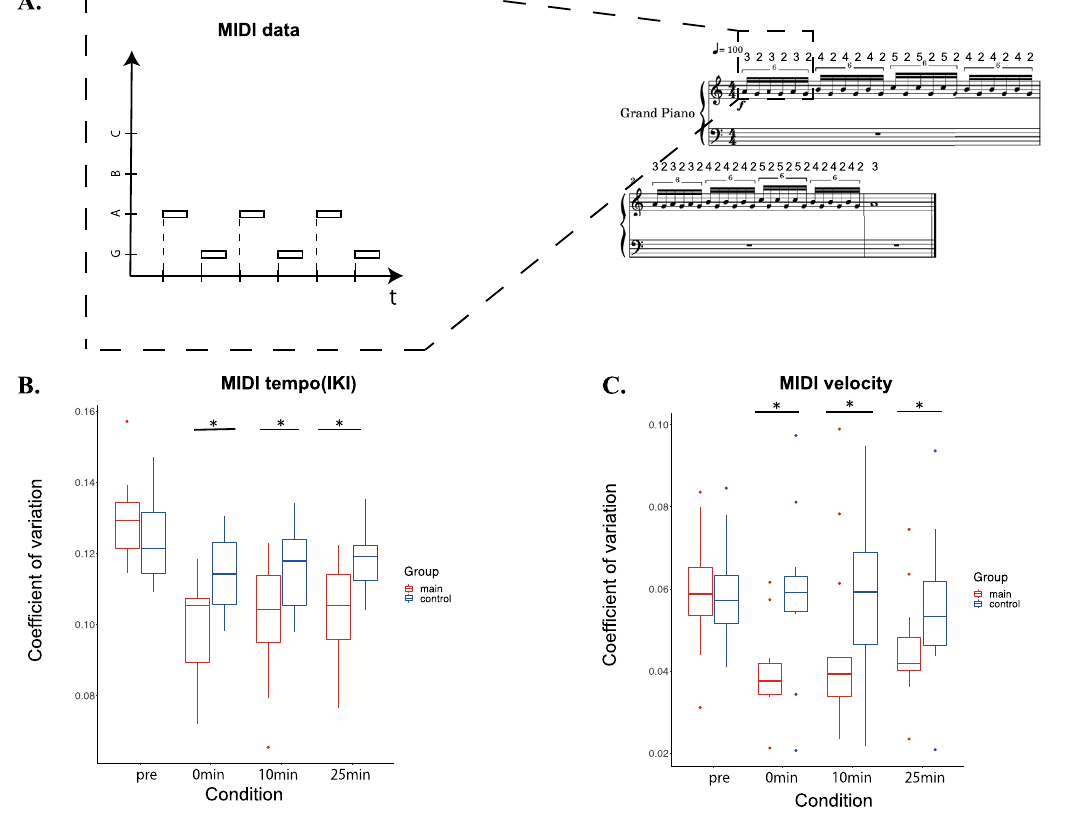
Figure 2. ( A ) A schematic illustration of the temporal information of the individual keystrokes representing a musical score representing the test task. ( B ) and ( C ) Box plots of the group means of the coefficients of variation (CV) of the timing (MIDI Inter-keystroke Intervals: IKI) and velocity (MIDI velocity) of the keypresses before and after the conditioning session (i.e. condition in the x-axis) in the main (red box) and control (blue box) groups. *: p <